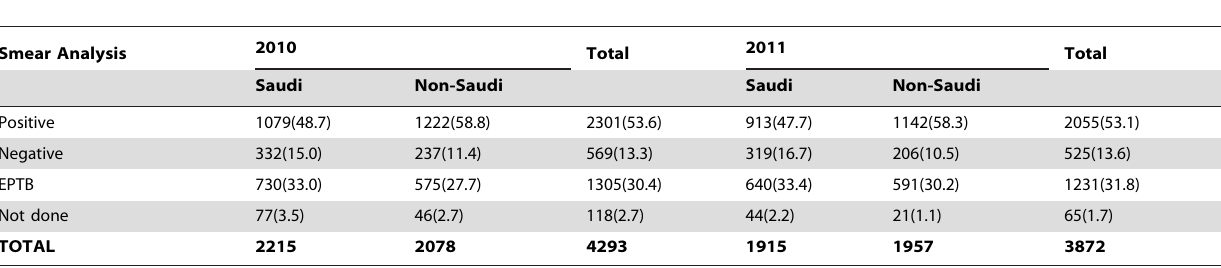
Table 3. The distribution of smear positives, negative and EPTB in new tuberculosis patients in Saudi Arabia by nationality and